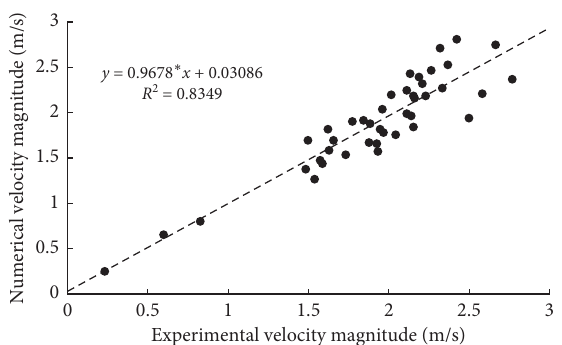
Figure 5: Comparison of flood velocity magnitudes under 100-year